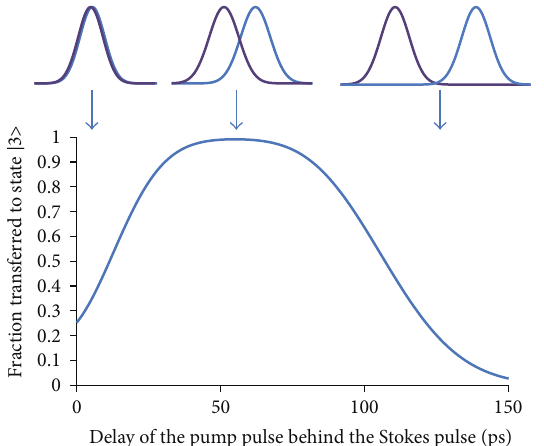
Figure 7: Fraction of molecules transferred into state |3⟩ as a function of the delay between the pump and Stokes pulses. This calculation was performed with Gaussian laser pulses with a full width at half max = 62ps and Ω 𝑝 = Ω 𝑠 = 0.213 × 10 12 rad/s (area = 20 radians). The insets at the top indicate the relative timing of the pulses. The violet curve represents Ω 𝑠 . The blue curve represents Ω 𝑝 .